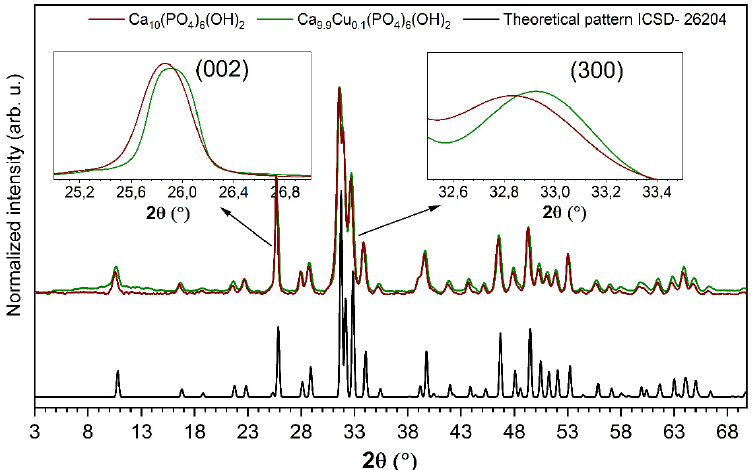
Figure 1. X-ray di ff raction patterns of pure nanohydroxyapatite (nHAp) and nHAp doped with 1 mol% Figure 1. X-ray diffraction patterns of pure nanohydroxyapatite (nHAp) and nHAp doped with 1 Cu 2 + after heat treatment at 400 ◦ C with the indication of (002) and (300) planes shift induced by doping mol% Cu 2+ after heat treatment at 400 ˚ C with the indication of (002) and (300) planes shift induced by with Cu 2 + doping with Cu 2+ ions.